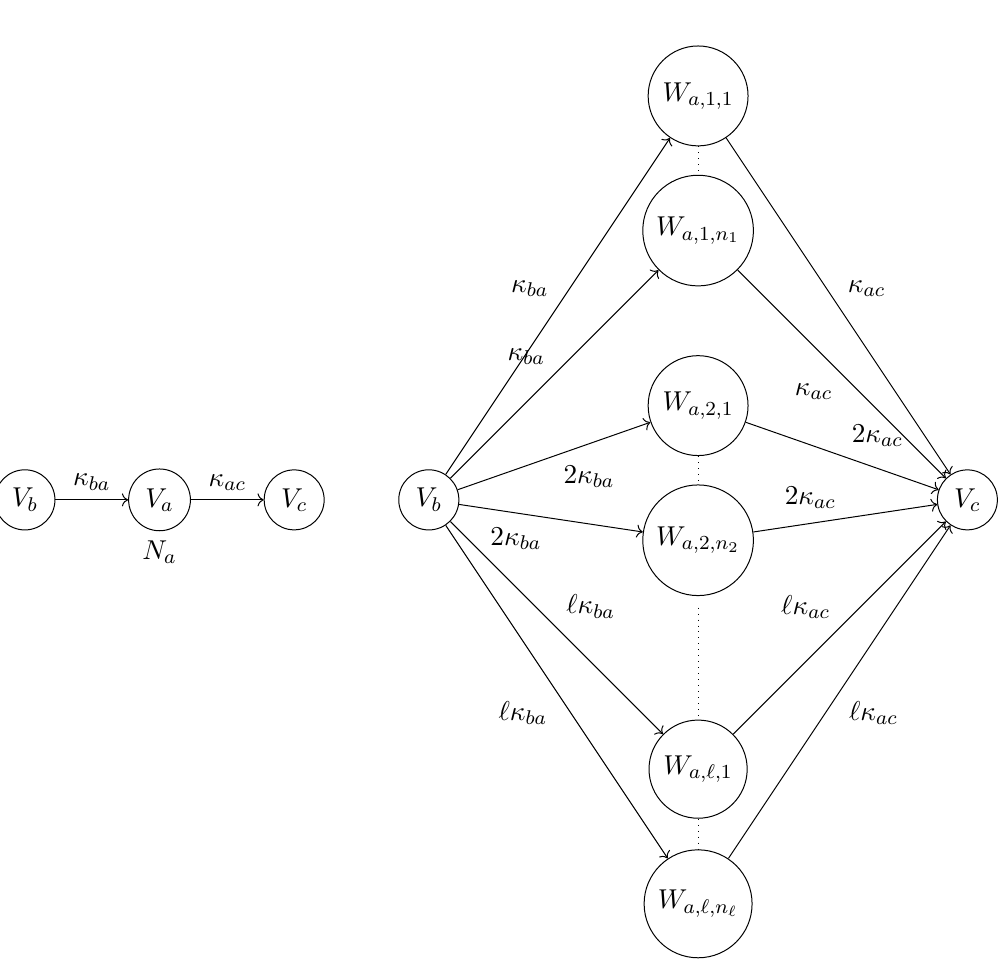
Figure 1 . Blowing up a non-Abelian node of rank N a = P nodes (on the right). The number of arrows from W a;‘;m to V b is ‘ times the number of arrows from V a to V b , where ‘ is the level of the node W a;‘;m . This operation may be performed on any number of non-Abelian